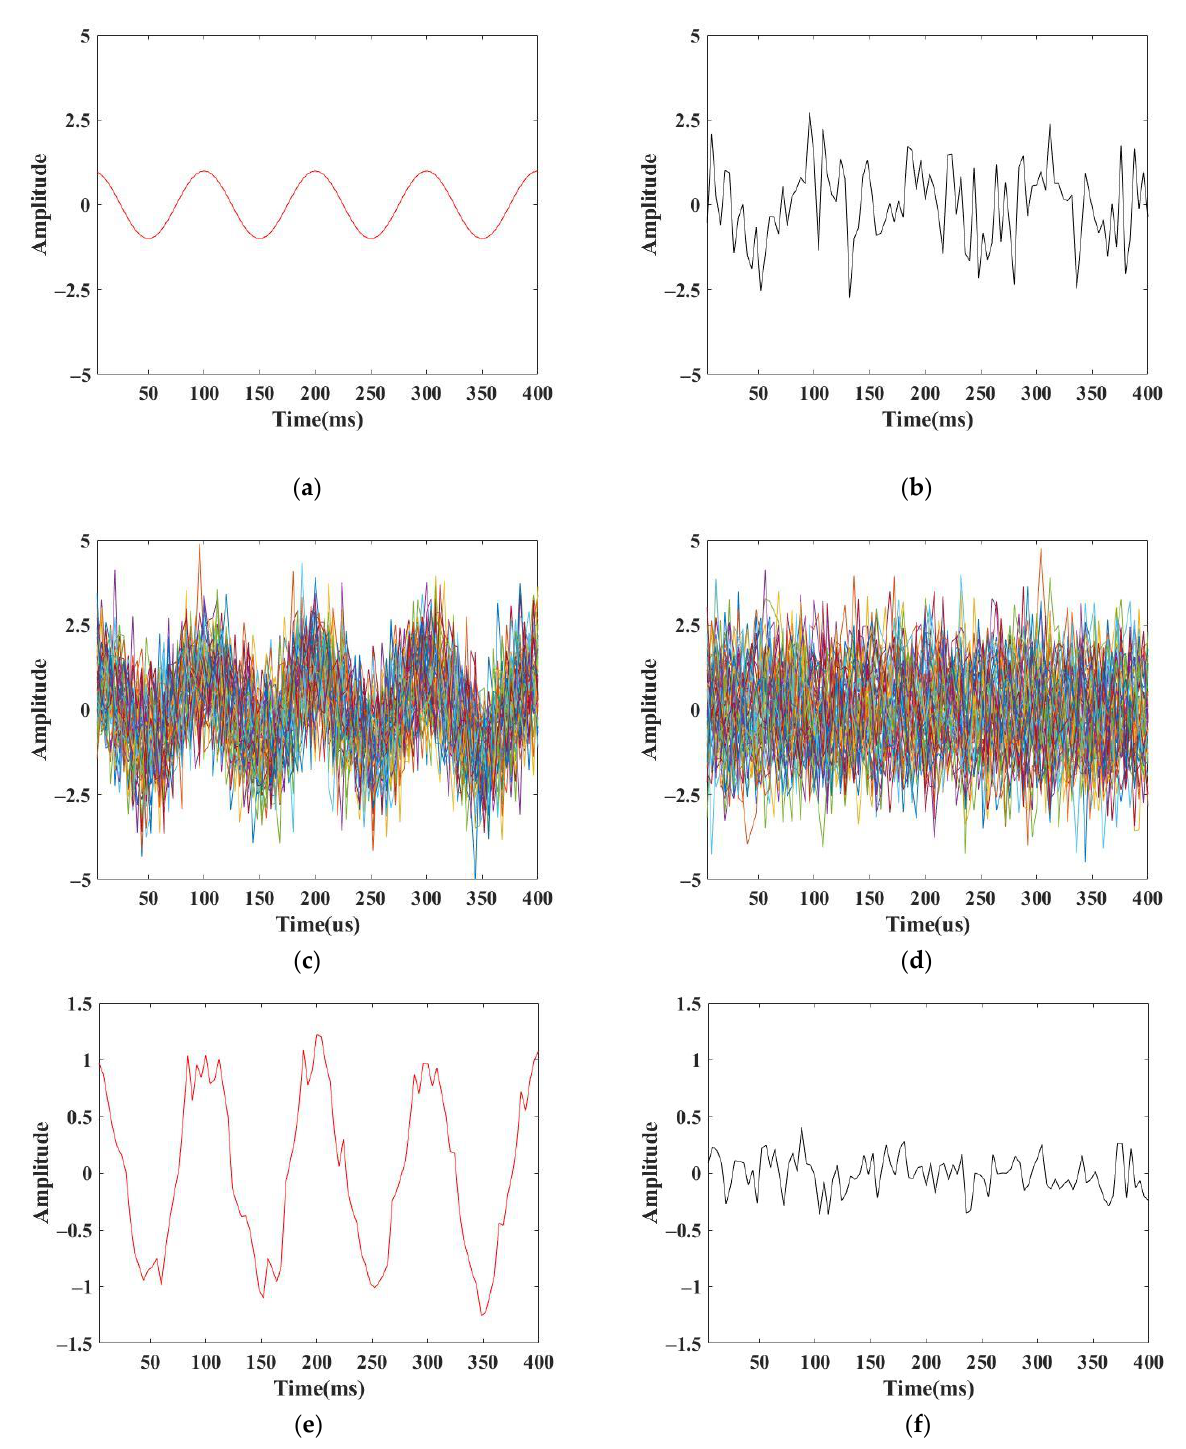
Figure 3. Simulation results: ( a ) one trace of the simulated sinusoidal signal; ( b ) one trace of the simulated sinusoidal signal with random noise; ( c ) sinusoidal signals with same initial phase bias; ( d ) sinusoidal signals with changing initial phase bias; ( e ) signals with the same initial phase bias after averaging; ( f ) signals with a changing initial phase bias after averaging.